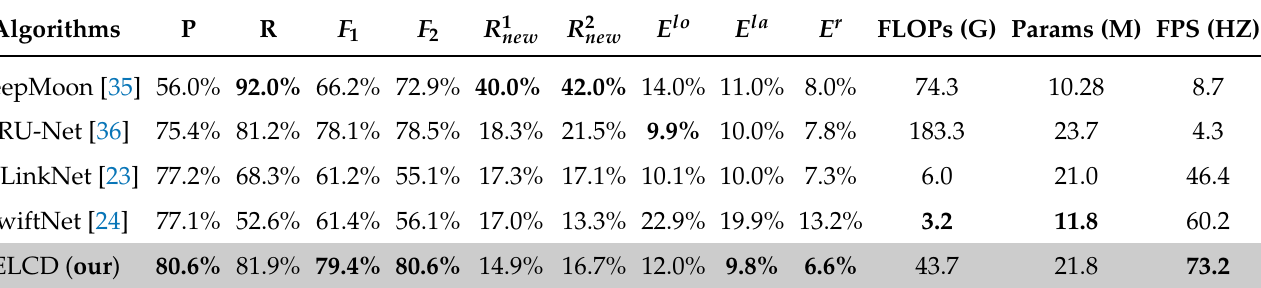
Table 3. Comparison of the detection results of test sets under various crater detection